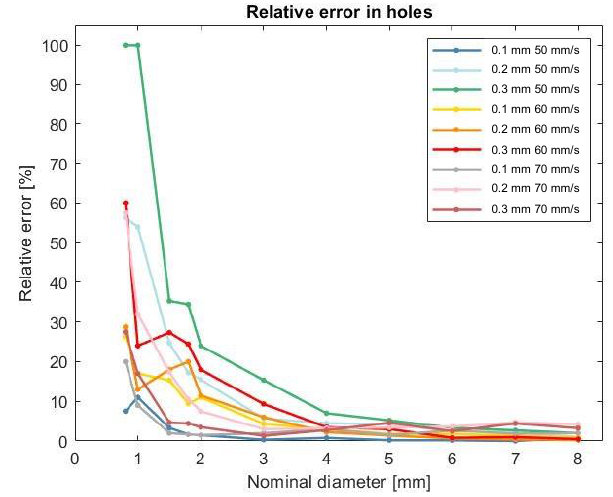
Figure 5. Relative error in holes as a function of the nominal diameter varying the printing speed. However, an unexpected result has been derived by comparing the relative error using the same layer height and varying the printing speed. Figure 6 shows how for a small value of the nominal diameter, the relative error will be small for the combinations of parameters (printing speed = 50 mm/s, layer height = 0.1 mm); (printing speed = 60 mm/s, layer height = 0.2 mm); and (printing speed = 70 mm/s, layer height = 0.3 mm). This can be explained by the fact that the amount of extruded material (which depends on the set of layer height set) must be in accordance with the speed at which it is placed on the piece.